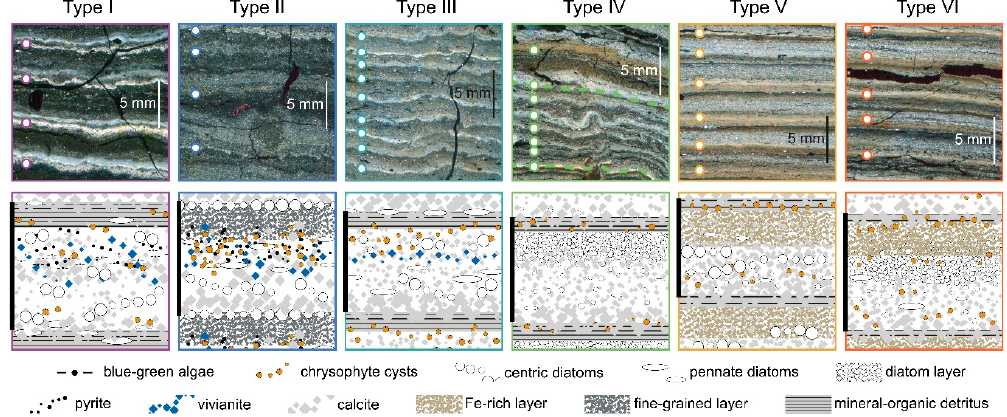
Figure 2. Top: Six varve microfacies (types I–VI) of Lake Ż abi ń skie (thin sections scanned with polarized light). White dots mark the beginning of each varve year. Bottom: Conceptual varve models. Black bars indicate one year.